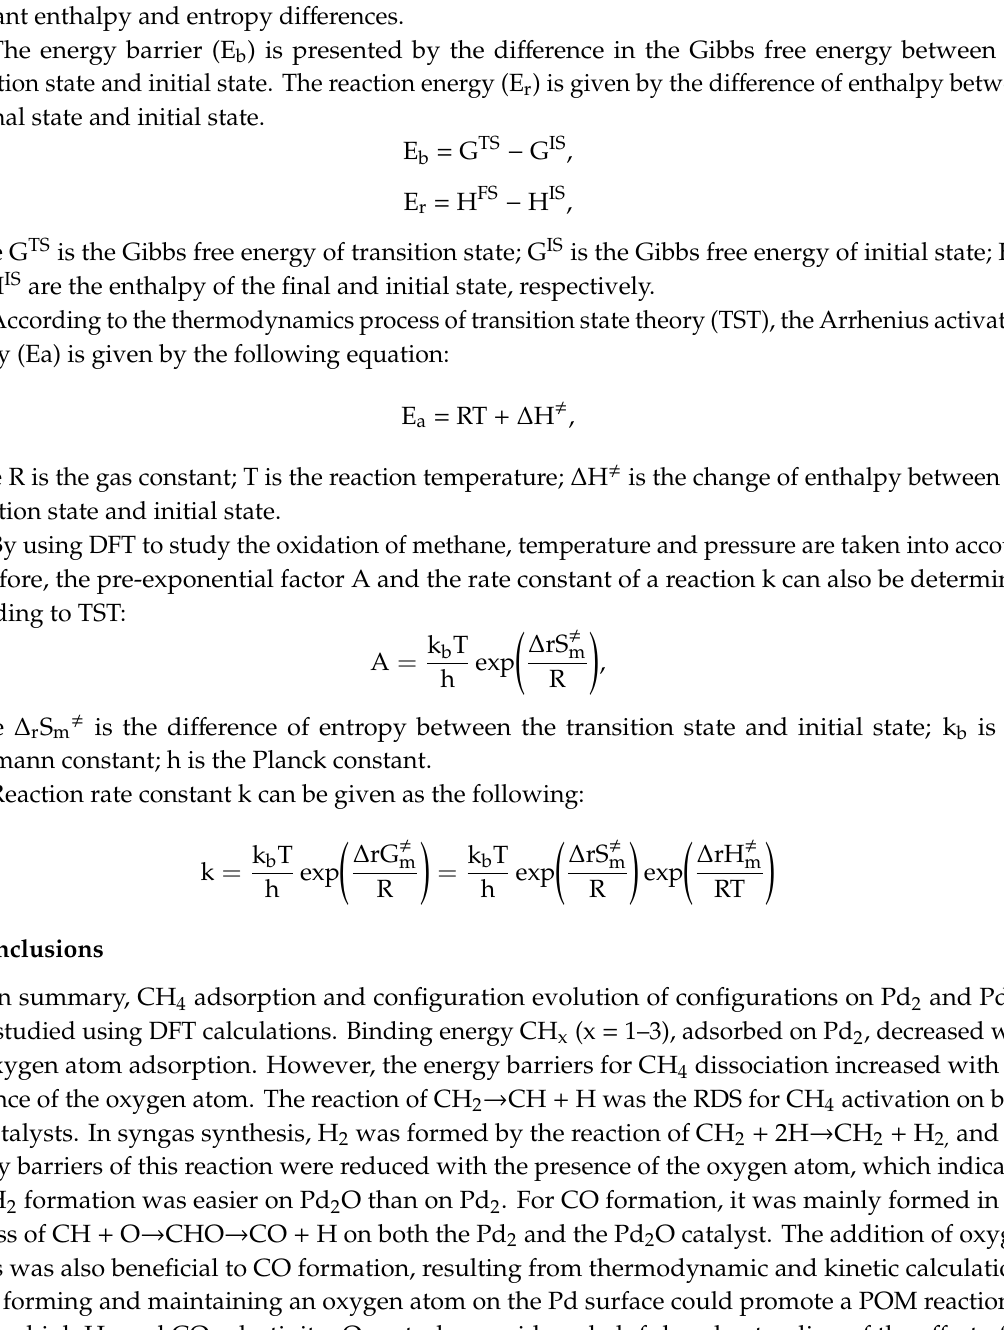
Table S1: Gibbs free energies (G), energy barriers (E b ), enthalpies (H), and reaction energies (E r ) in the process of methane activation by Pd 2 . Table S2: Gibbs free energies (G), energy barriers (E b ), enthalpies (H) and reaction energies